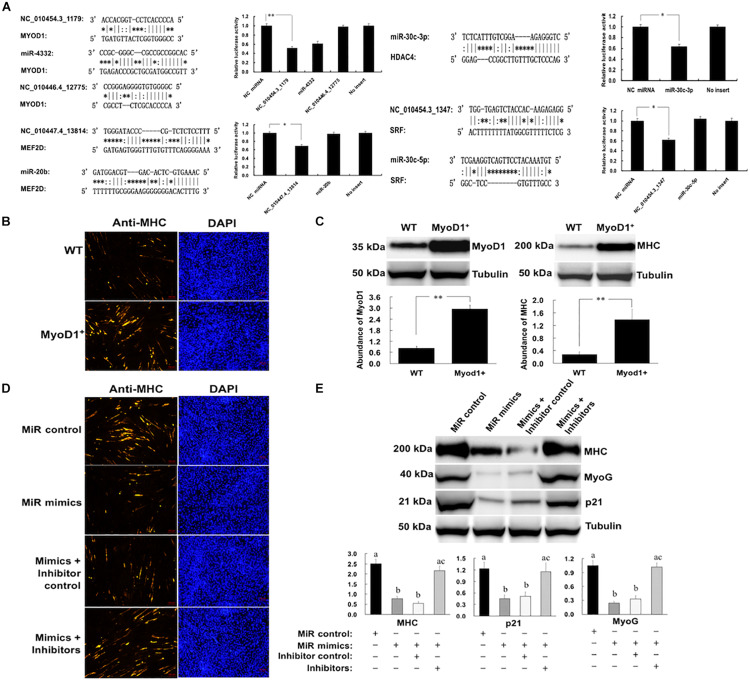
Regulation of porcine myogenesis by NC_010454.3_1179. (A) Validation of critical novel miRNA-mRNA regulatory pairs by luciferase assays. HEK293 cells were transfected with miRNA mimics and plasmids carrying the 3′UTR of target genes. NC: negative control miRNA (∗P < 0.05, ∗∗P < 0.01); (B) Effect of MyoD1 overexpression on myogenesis. The porcine myoblasts cultured in growth medium were electroporated with plasmid pcDNA.3.1 (WT) or pcDNA.3.1-MyoD1 (MyoD1+). Cells were continuously cultured in growth medium for 24 h after transfection and then transferred to differentiation medium for 36 h before immunostaining for MHC. (C) Shows the western blot analysis of the MyoD1 and MHC in the WT and MyoD1+ cells (∗P < 0.05, ∗∗P < 0.01). (D,E) Cells were electroporated with miRNA mimics, miRNA inhibitors, or their controls. Cells were cultured in growth medium for 24 h after transfection and then transferred into differentiation medium for 12 before western blot analysis of p21 and MyoG, or 36 h before western blot analysis for MHC (a,bMeans in a same column with different letters differ significantly, P < 0.05).